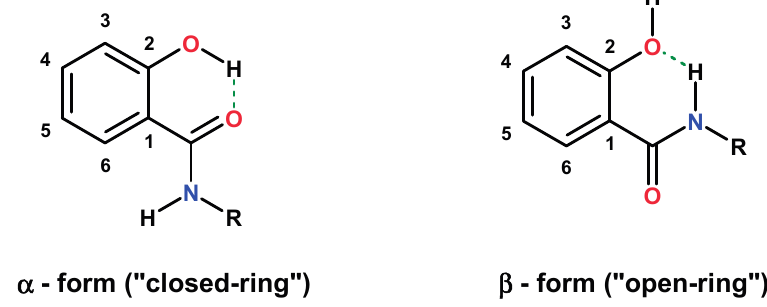
Figure 1. Intramolecular hydrogen bonding modes in